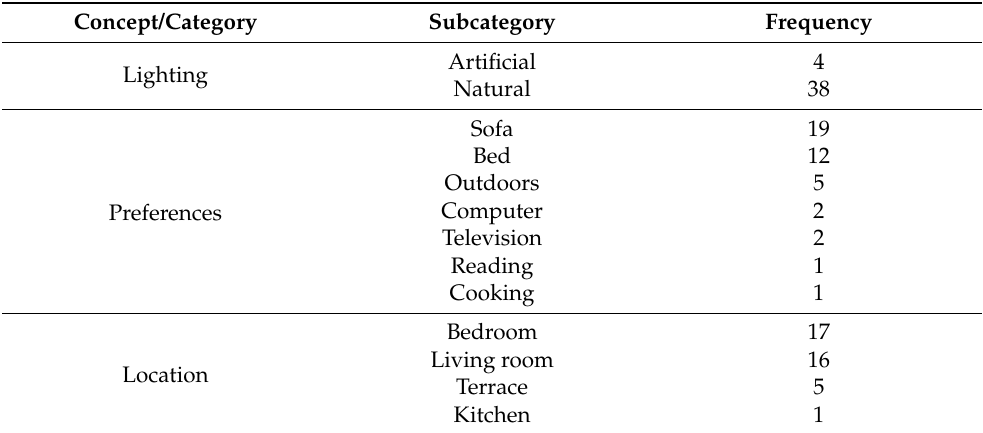
Table 2. Categorization of pictures’ content related to the most comfortable space.